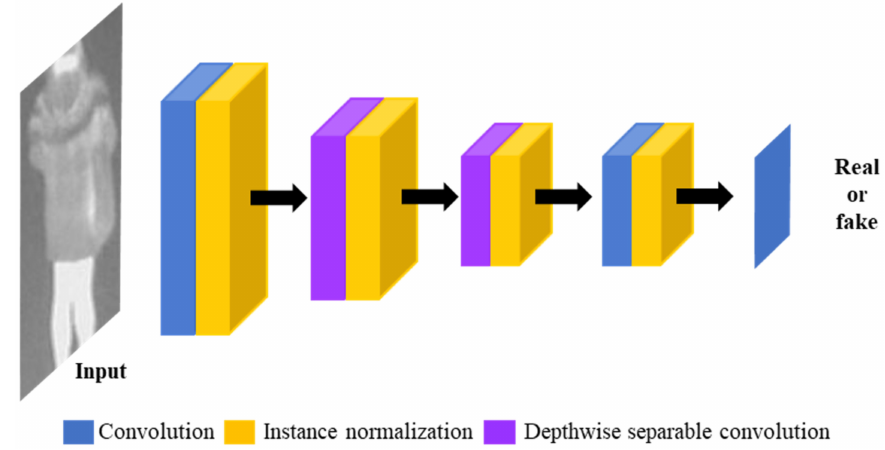
Figure 6. Description of the SI-AGAN discriminator. Table 6. Architecture of attention-guided discriminator. (Conv, DWConv, IN, and LReLU refer to convolution layer, depthwise separable convolution layer, instance normalization, and leaky rectified linear unit, respectively; N* indicates a number from 1 to 9; for IN*, IN is executed until reaching the epoch corresponding the pre-determined switch parameter, and IN is not executed